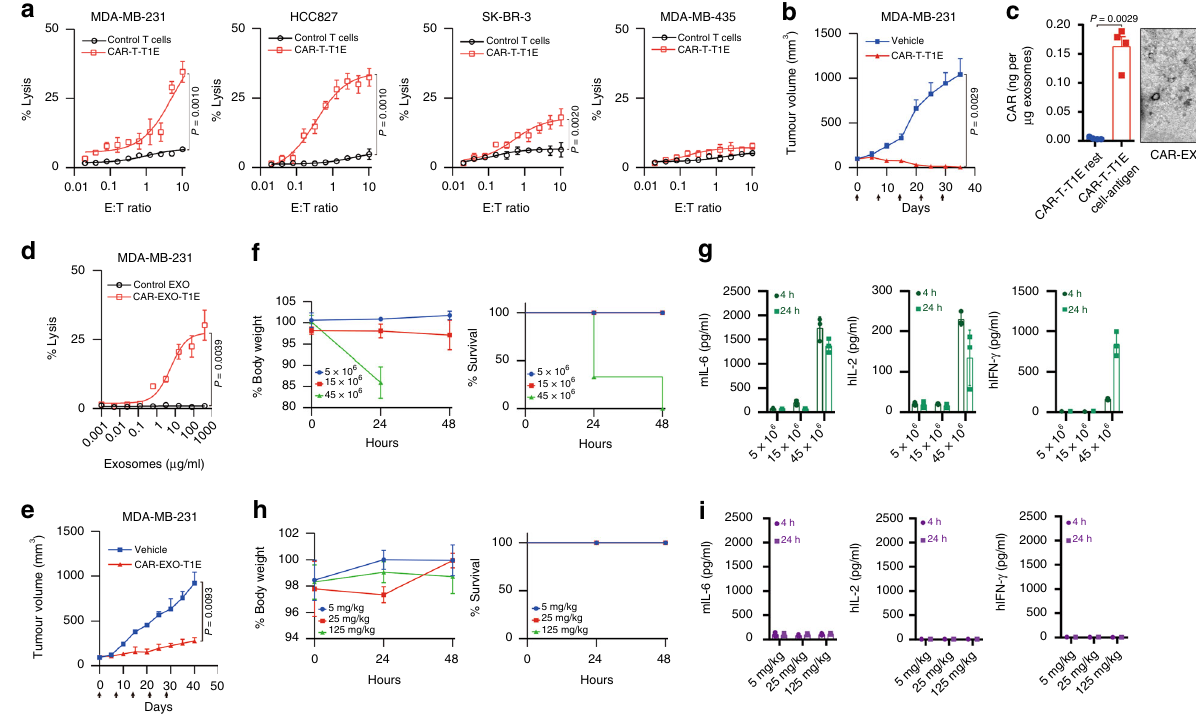
Fig. 7 CAR exosomes do not cause cytokine release syndrome in mice. a Killing activity of CAR-T-T1E cells in response to tumour cells. The cytotoxic activity of CAR-T-T1E and control T cells against cancer cell lines was assessed by the 51 Cr-release assay at the indicated effector-to-target (E:T) ratios. b Tumour volumes of MDA-MB-231 tumour xenografts after the indicated treatment, n = 8. c ELISA (left) of CAR on exosomes from CAR-T-T1E and transmission electron micrographs of CAR-EXO-T1E (right). Scale bars = 100 nm. d Cytotoxic activity of CAR exosomes and control T cells against cancer cell lines was assessed by the 51 Cr-release assay at the indicated concentration. e Tumour volumes of MDA-MB-231 tumour xenografts after the indicated treatment, n = 8. Arrows indicate the treatment point ( e ). f Three groups of three tumour-free mice were treated i.p. with CAR-T-T1E cells at the indicated escalating doses. Serial weight measurements were performed and normalized to the starting body weight for each animal. The Kaplan – Meier survival curve of mice in all three groups is shown on the right. g Serum levels of human (h) and mouse (m) cytokines, measured at the indicated time points. h Three groups of three tumour-free mice were treated i.p. with CAR-EXO-T1E cells at the indicated escalating doses. Serial weight measurements were performed and normalized to the starting body weight for each animal. The Kaplan – Meier survival curve of mice in all three groups is shown on the right. i Serum levels of human (h) and mouse (m) cytokines, measured at the indicated time points. Arrows ( b , e ) indicate the treatment point. Results shown represent three ( c ) independent experiments. The data are presented as the means ± s.d. of six ( a ); four ( c ) or three ( f – i ) independent biological replicates or means ± s.e.m. three ( f – i ) independent biological replicates. P values are from a nonparametric t test ( a , b , d , e ) or a two-sided unpaired t test ( c ). Source data ( a – i ) are provided as a Source Data fi